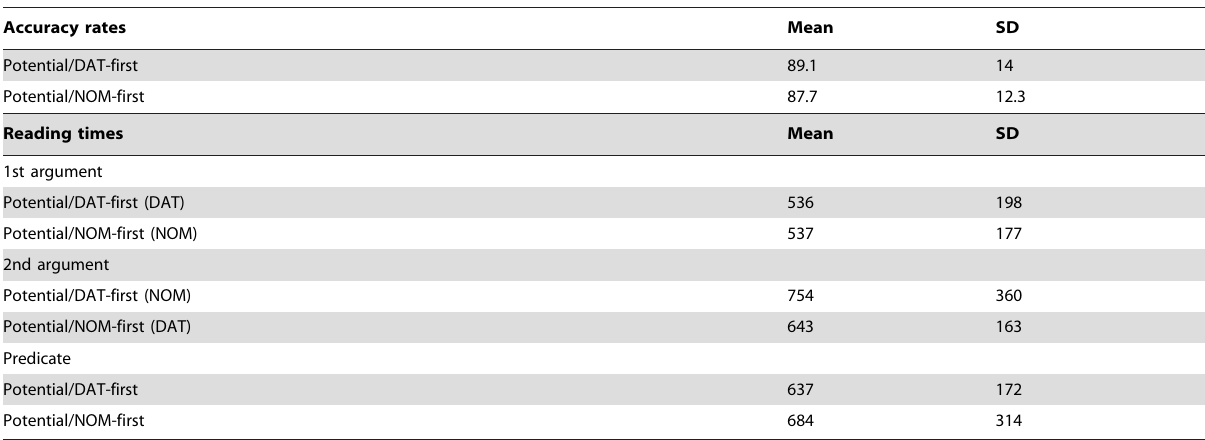
Table 2. Behavioral